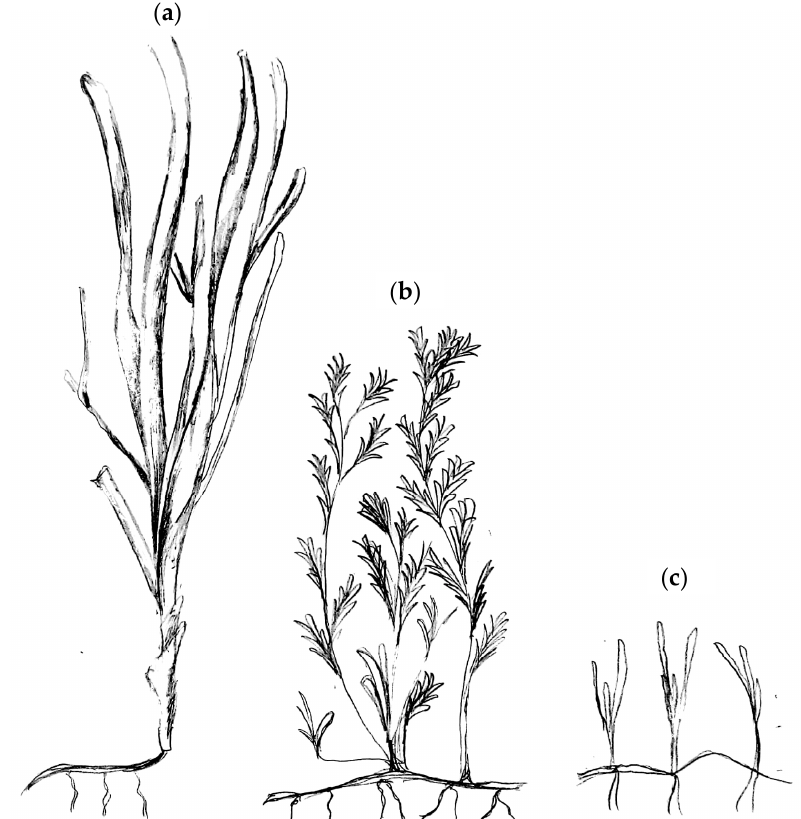
Figure 7. Schematic of seagrass leaf morphology for relative differences in sizes of (a) Posidonia , (b) Amphibolis , and (c) Heterozostera drawn by C. Hwang based on [82]. Note the differences in leaf sheath formation near the roots of each seagrass.